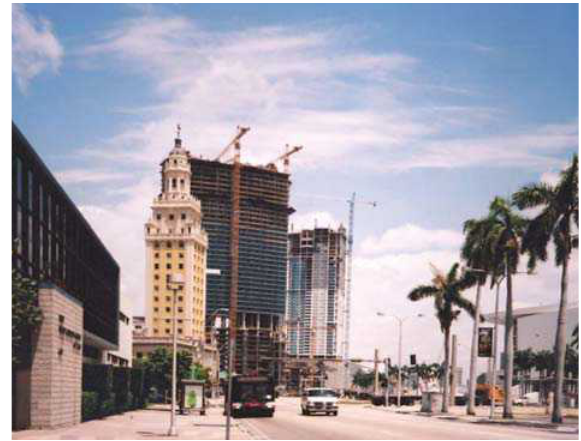
Fig 3. Freedom Palace in Florida. Improving the Palace exposition by refl ectional effects of closer expositional background (on the